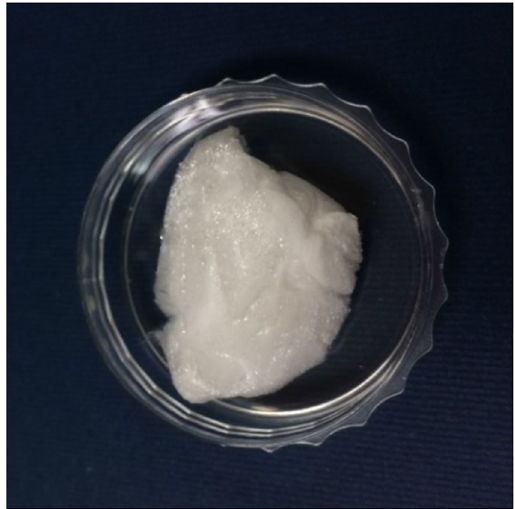
Figure 7. Lyophilized ELPs. The ELPs were synthesized, purified, and dialyzed with deionized water, followed by lyophilisation. A 10 wt% solution of lyophilized ELP was used as a liquid phase for the preparation of ELP- CPC